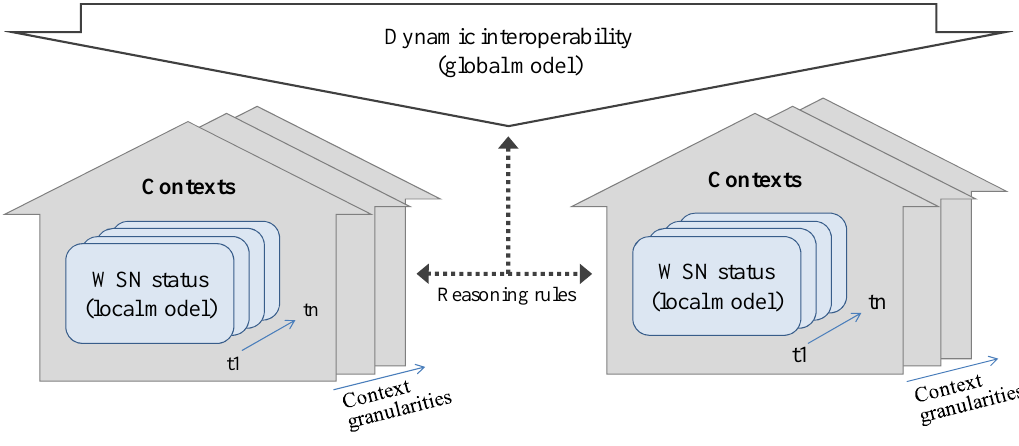
Figure 2. Contexts connecting WSN status with dynamic interoperability through reasoning rules.